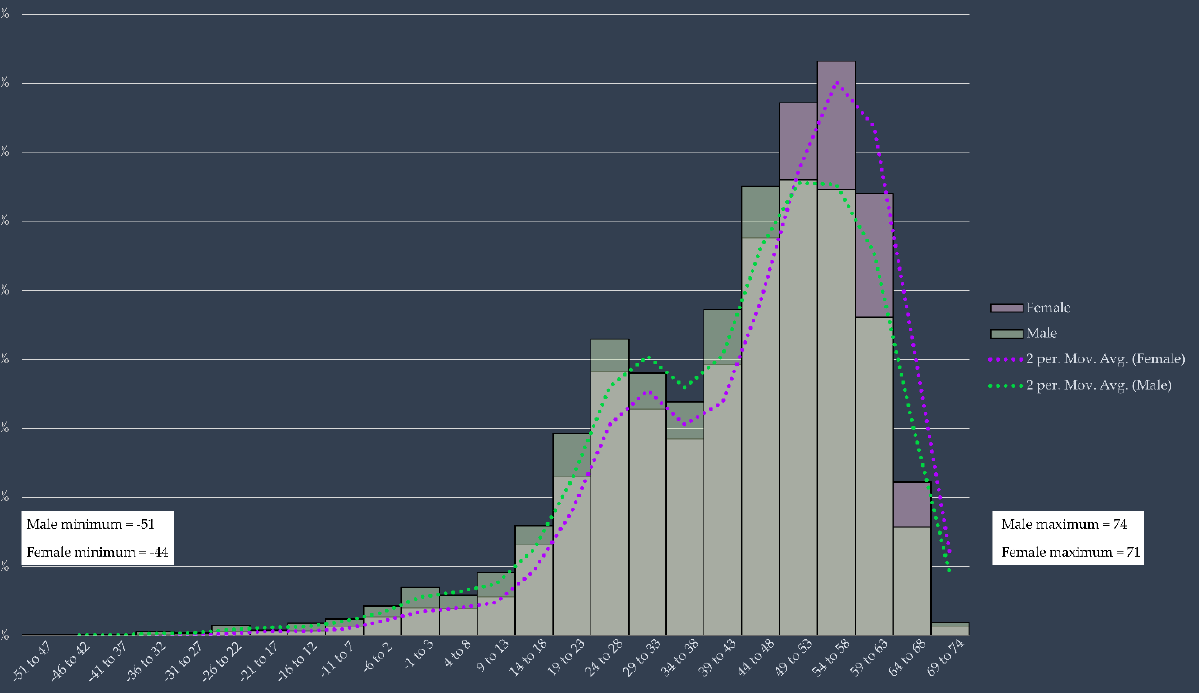
Figure 2. Numerical distribution of the perception of risk in the population.